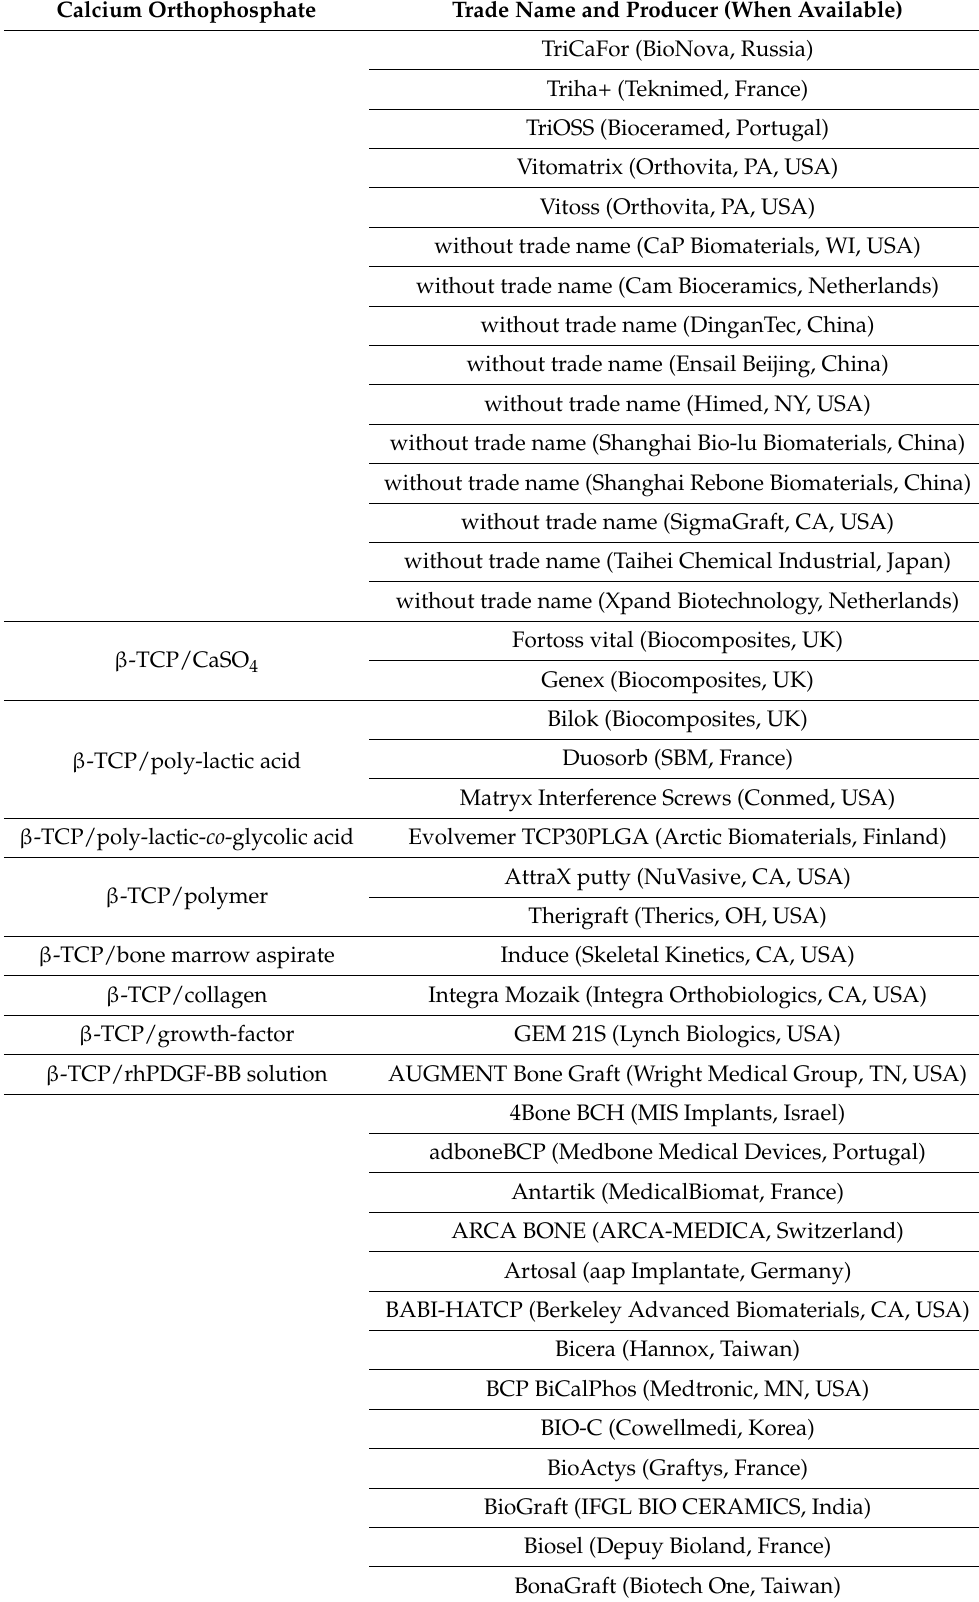
Table 3. Cont . Calcium